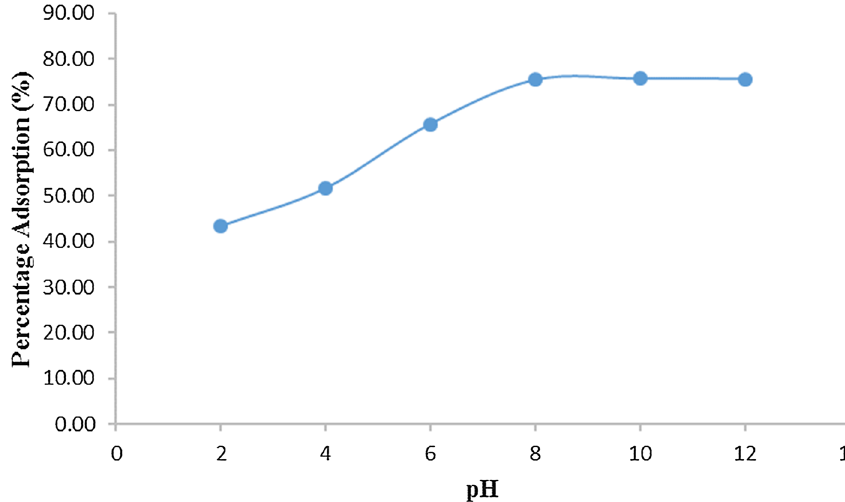
Fig.1 Influence of pH on cya- nide adsorption from cassava wastewater onto